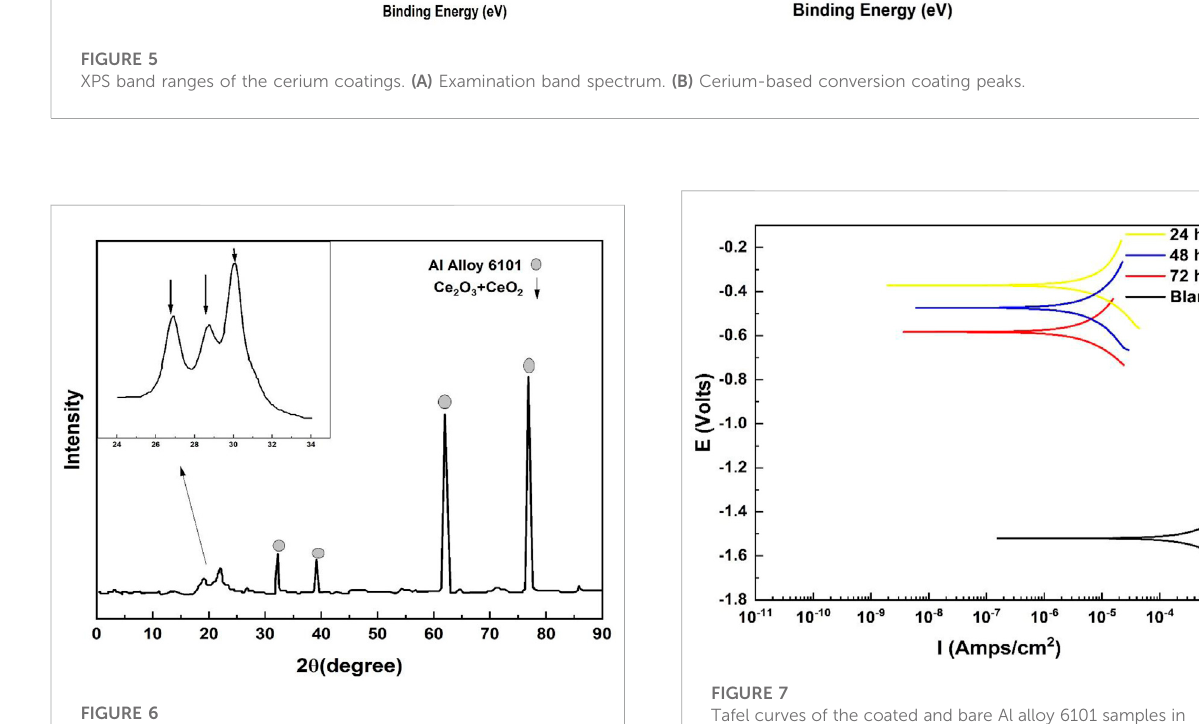
FIGURE 6 XRD peaks of the cerium coatings.